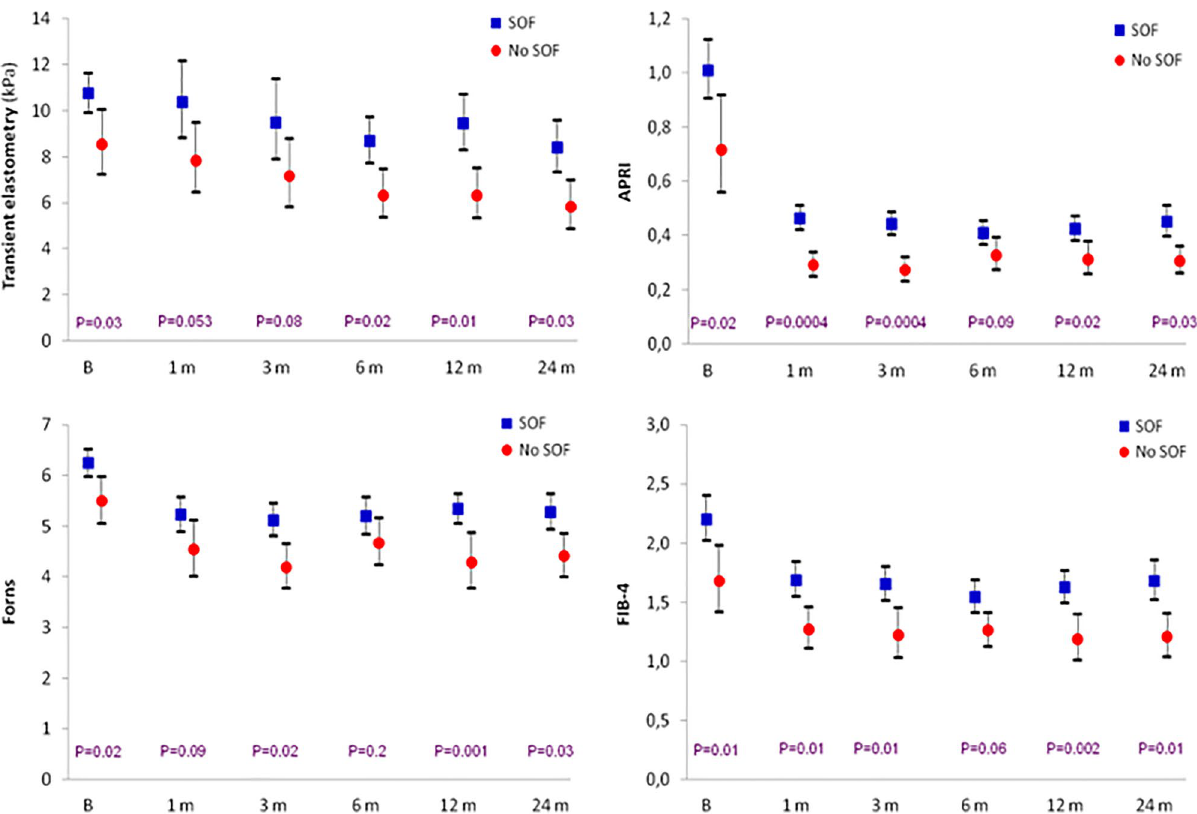
Figure 4. Course over time of the four fibrosis indexes in patients treated or not with sofosbuvir regimens (mean, 95% CI).